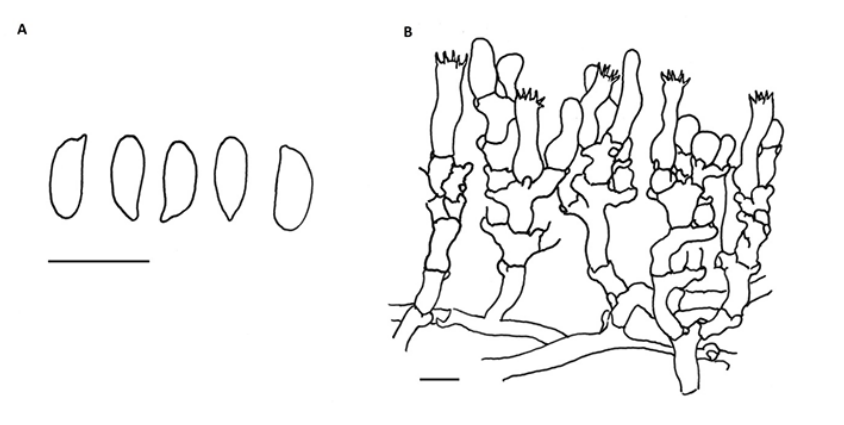
Figure 12 Microcharacters of Sistotrema athelioides Hallenb.: ( A ) spores; ( B ) basidia and hyphal system. Scale bars: 10 µ